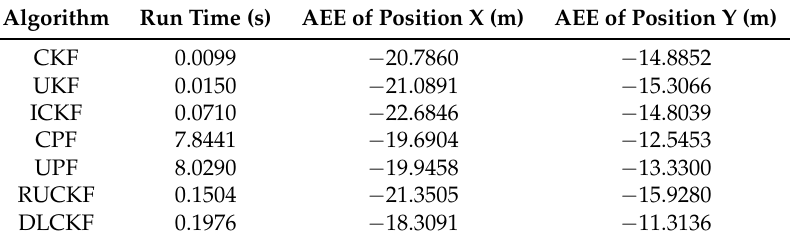
Table 4. Performance of each